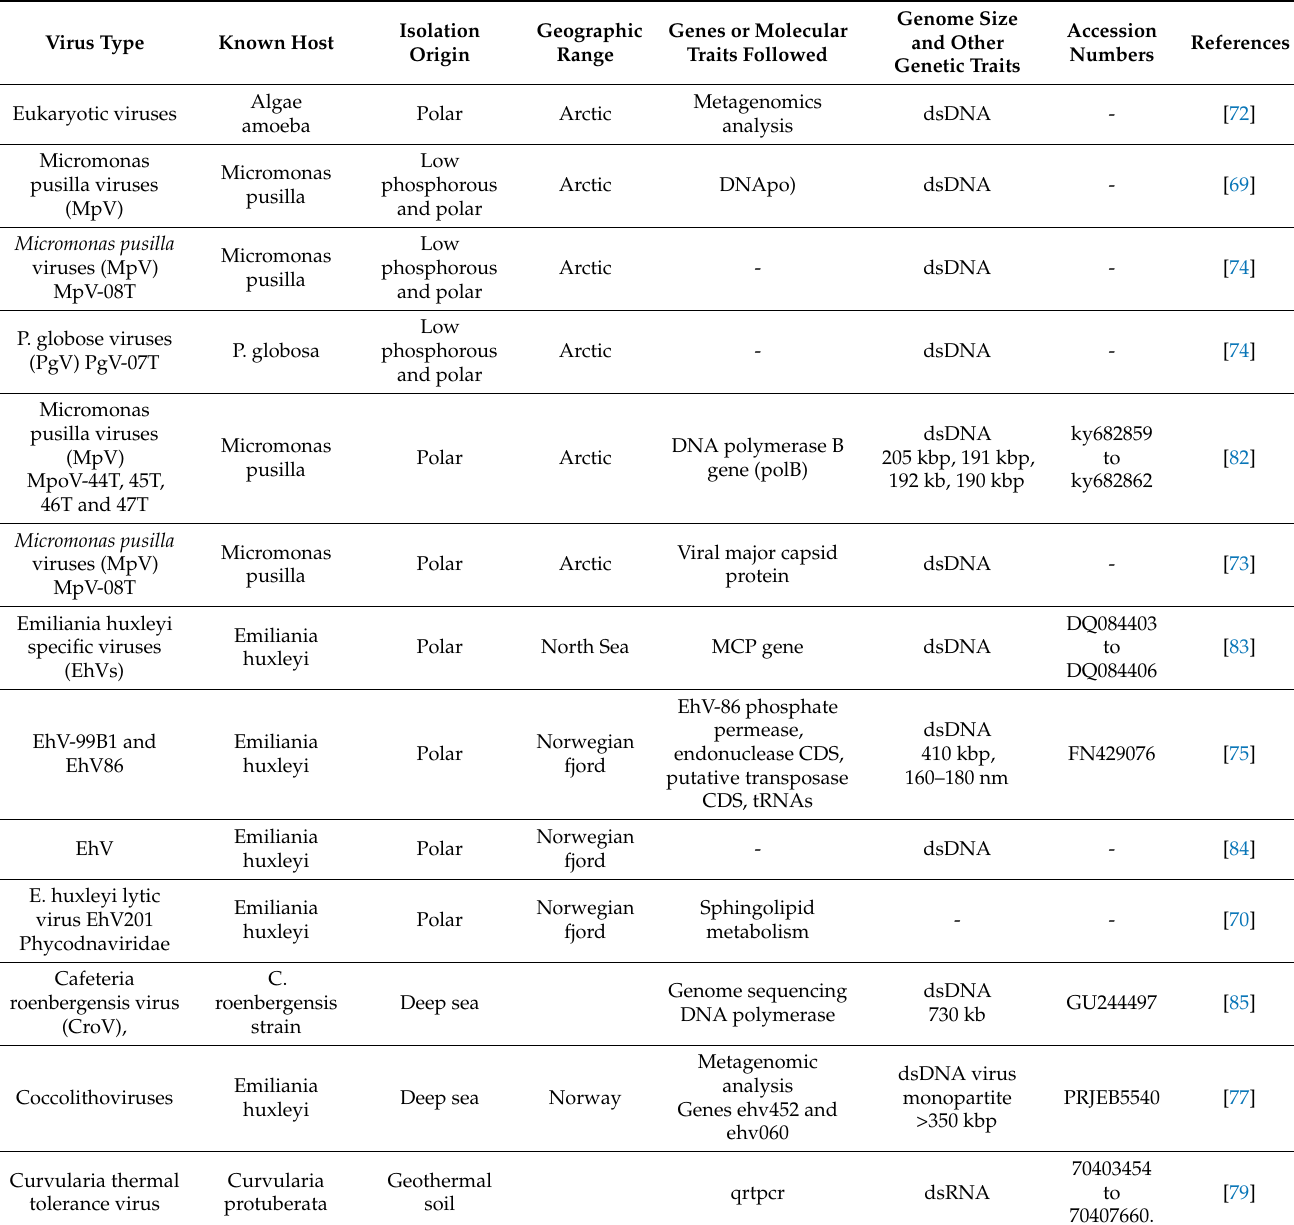
Table 4. Virus in extremophile eukaryotic